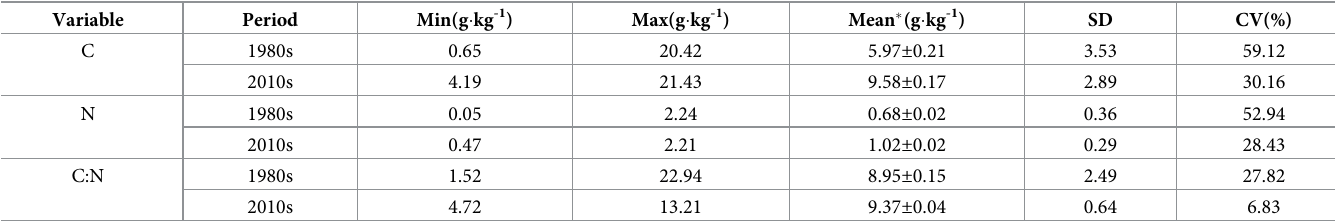
Table 1. Descriptive statistics of C, N contents and C:N